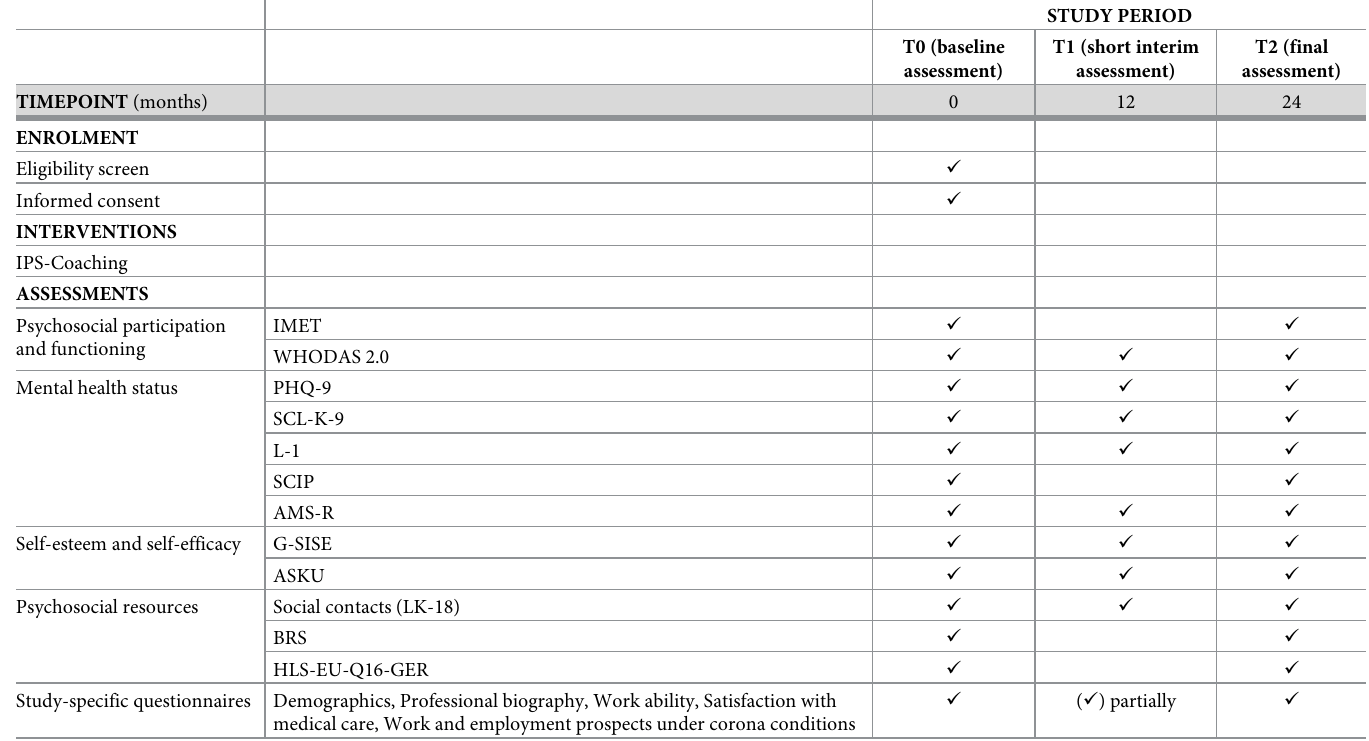
Table 1. Diagnostic instruments and assessment schedule (the full names of the instruments are given in the text, see